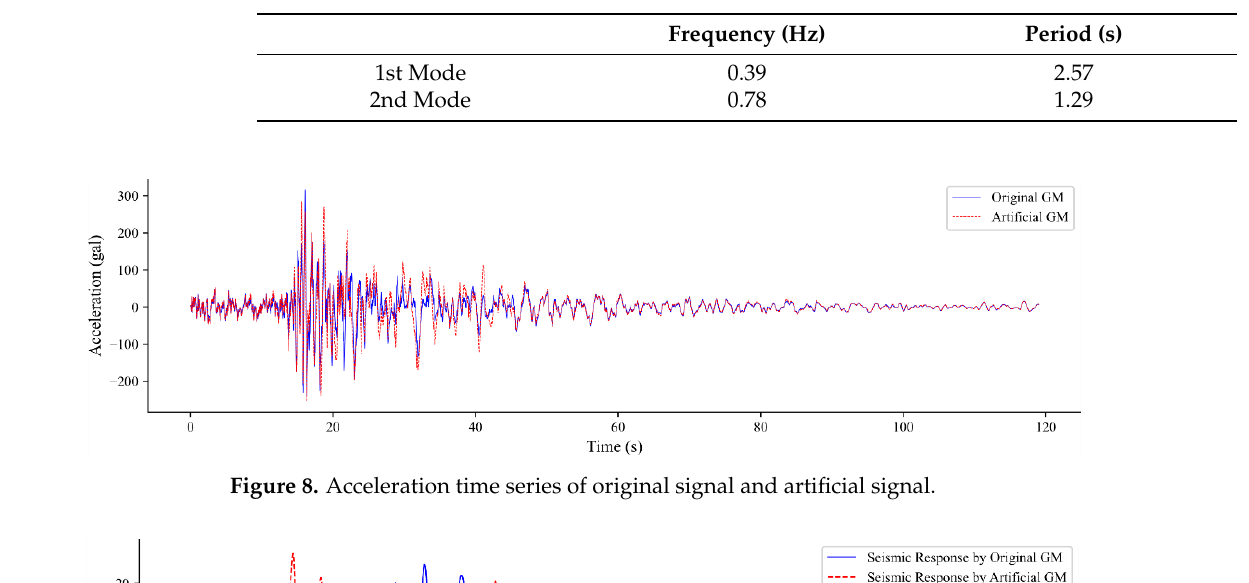
Table 1. Modal frequencies and periods of the analysis model.